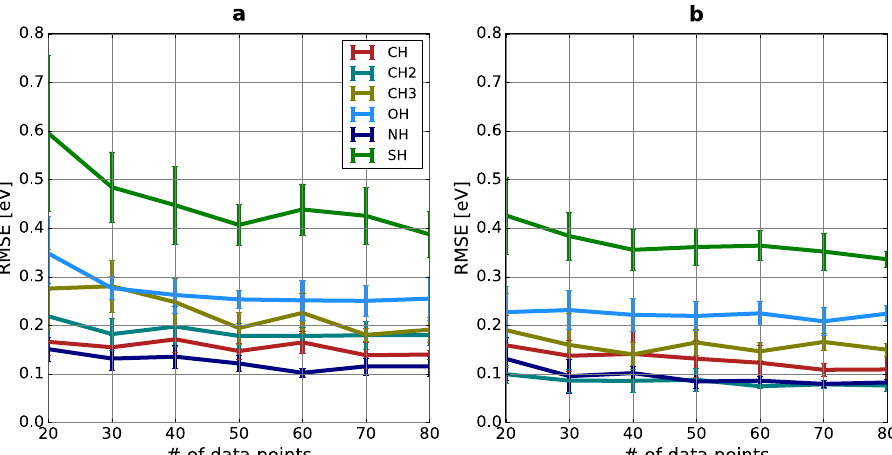
Fig. 4 Bayesian model selection (BMS) and Bayesian model averaging (BMA) performance plot. a BMS and b BMA. Mean RMSE in eV for 10 different runs are plotted against the number of data points used to train the